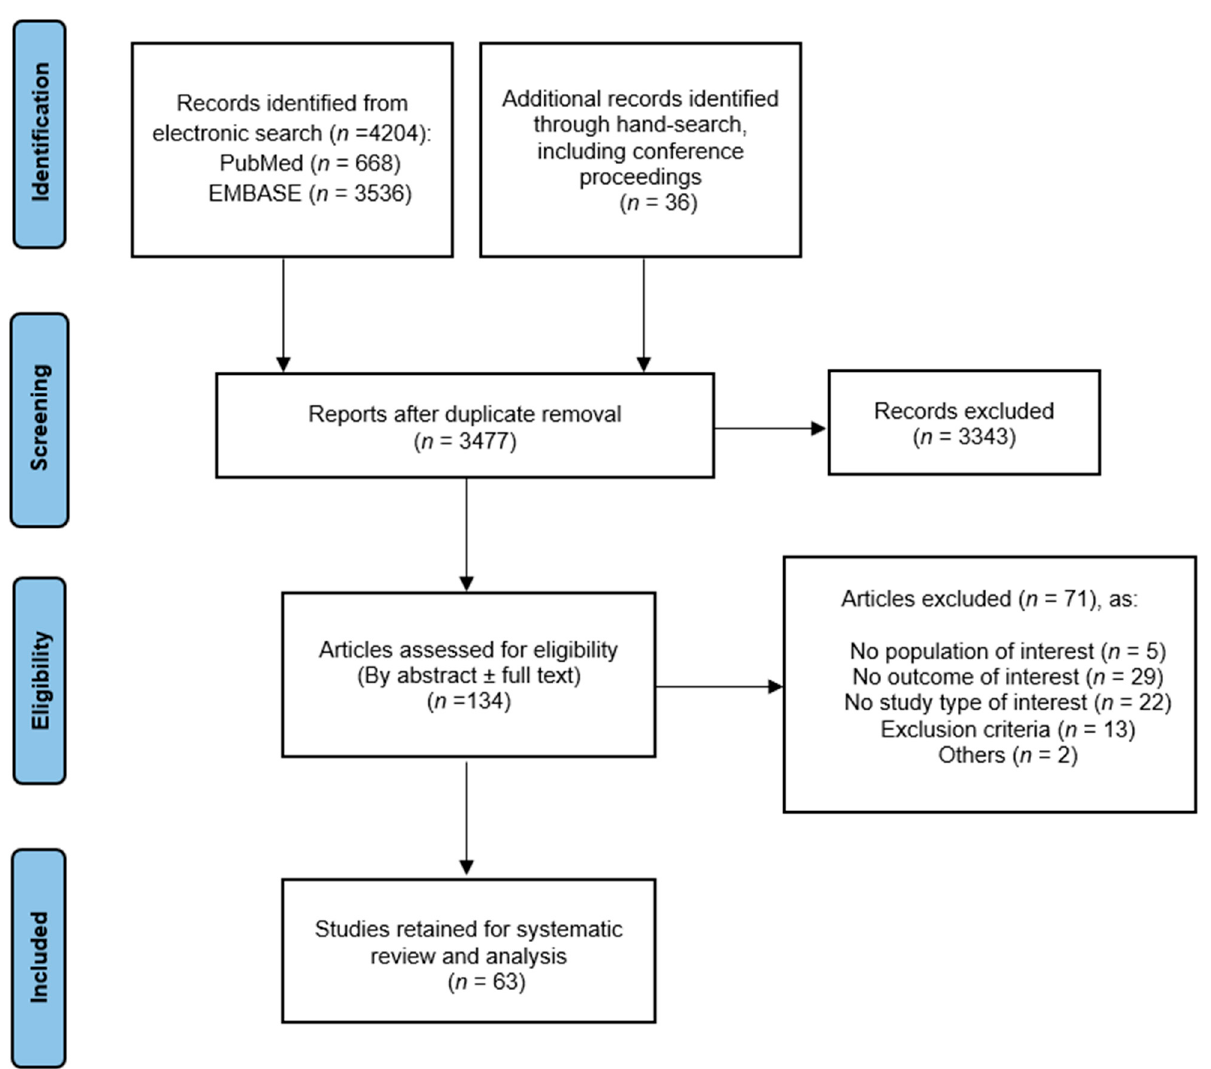
Figure 1. PRISMA flowchart of the screening and selection of relevant studies for inclusion in the meta-analysis.